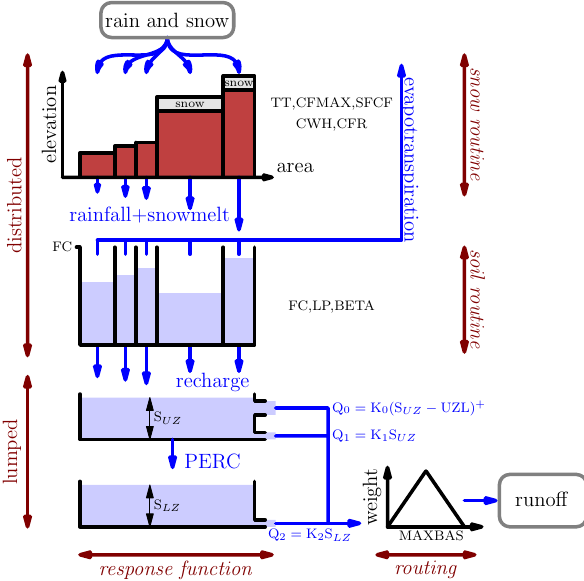
Fig. 2. A simplified schematisation of the HBV Light model (after Seibert